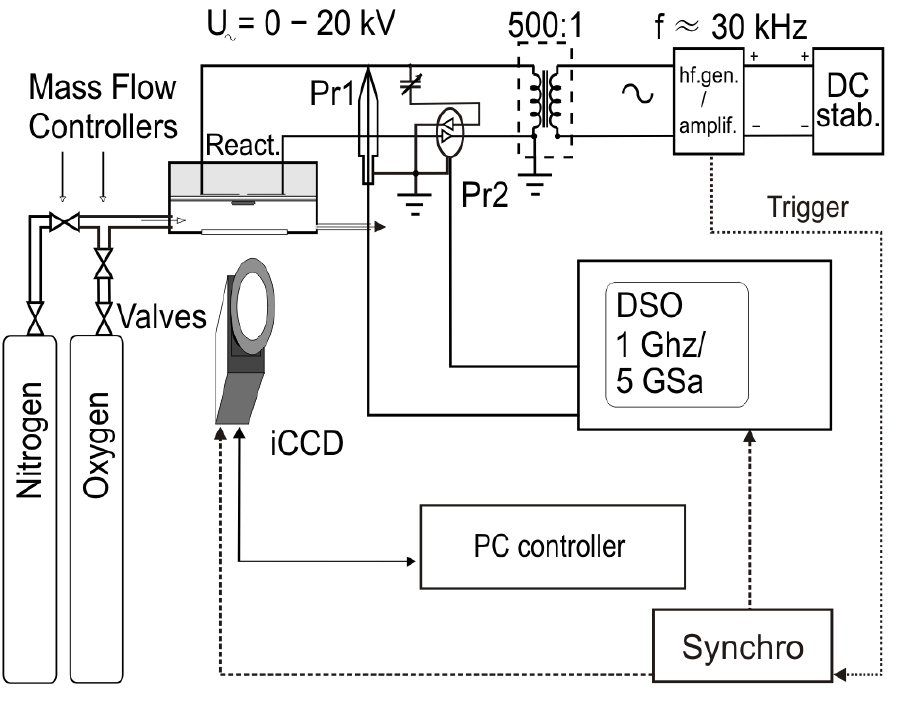
Figure 2 : Experimental setup: general scheme of discharge setup and time-resolved optical imaging of discharge